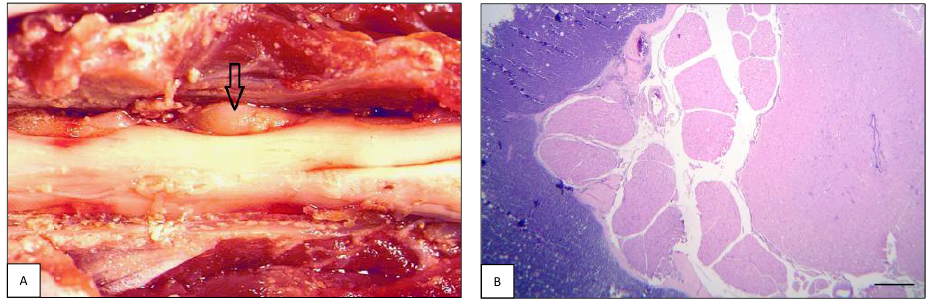
Figure 5. Feline intraspinal lymphoma. ( A ) Case #67. The thoracic spinal cord is focally compressed by an extradural lymphoma (open arrow). ( B ) Case #53. Lumbar spinal cord. Extradural accumulation of neoplastic lymphocytes with only minimal infiltration of the dura mater (H&E, bar = 1 mm). Intradural-extramedullary lymphoma was observed in only three (3/21; 14.3%) feline cases, either as a primary or multicentric form. They were all T-cell lymphomas